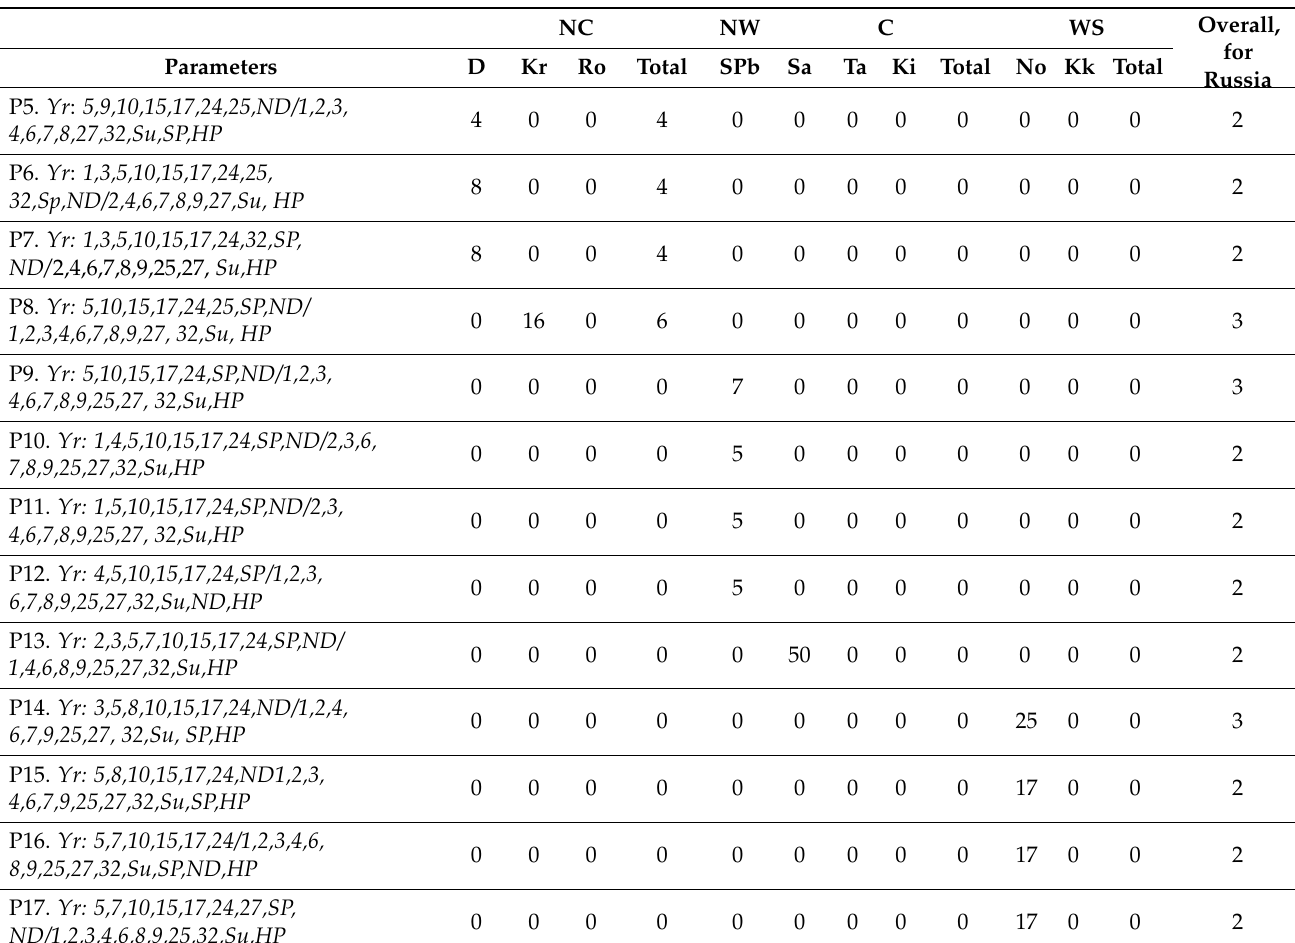
Table 4. Cont . NC NW C WS Overall,